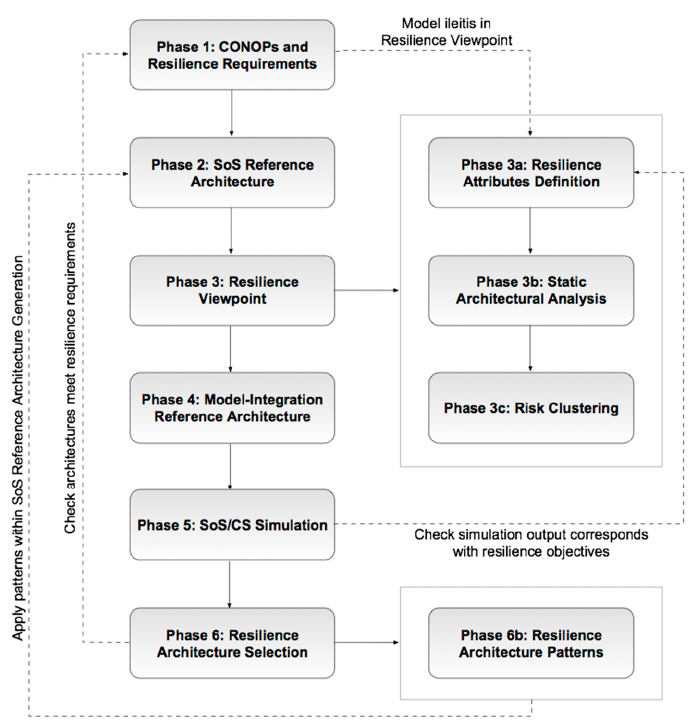
Figure 3. System-of-systems (SoS) resilience methodology.